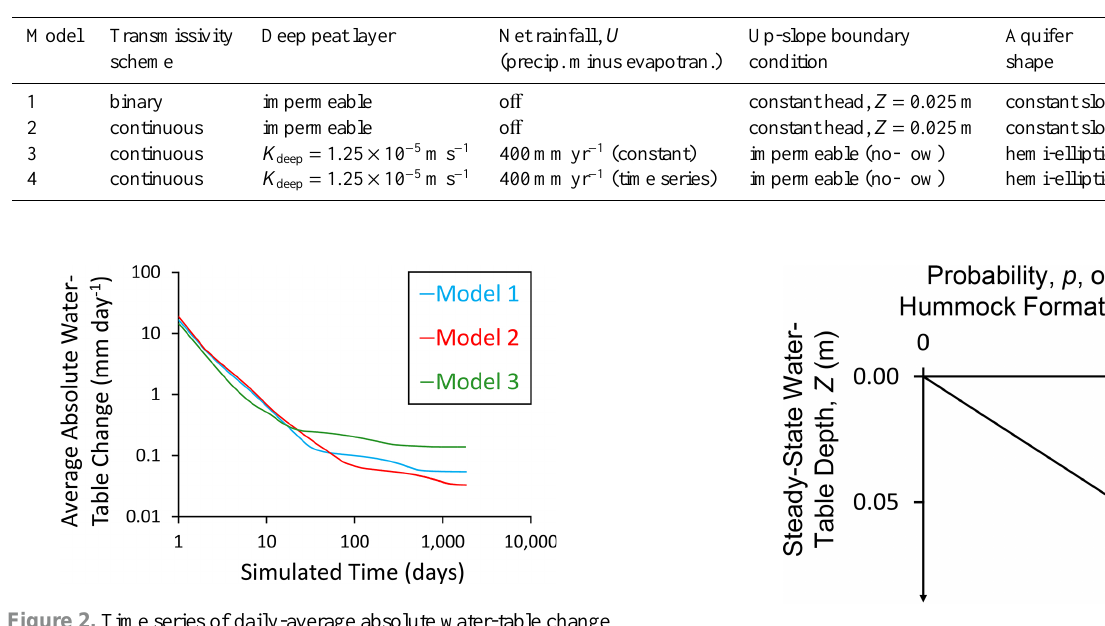
Table 2. Summary of the four models and the objectives addressed by each.